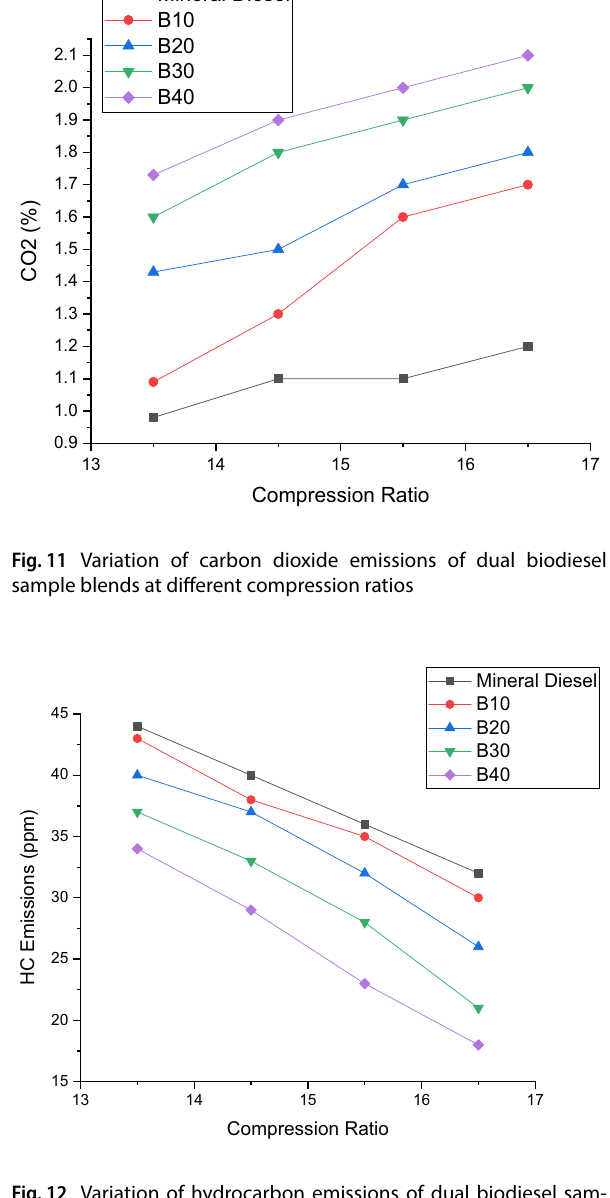
Fig. 12 Variation of hydrocarbon emissions of dual biodiesel sam- ple blends at different compression